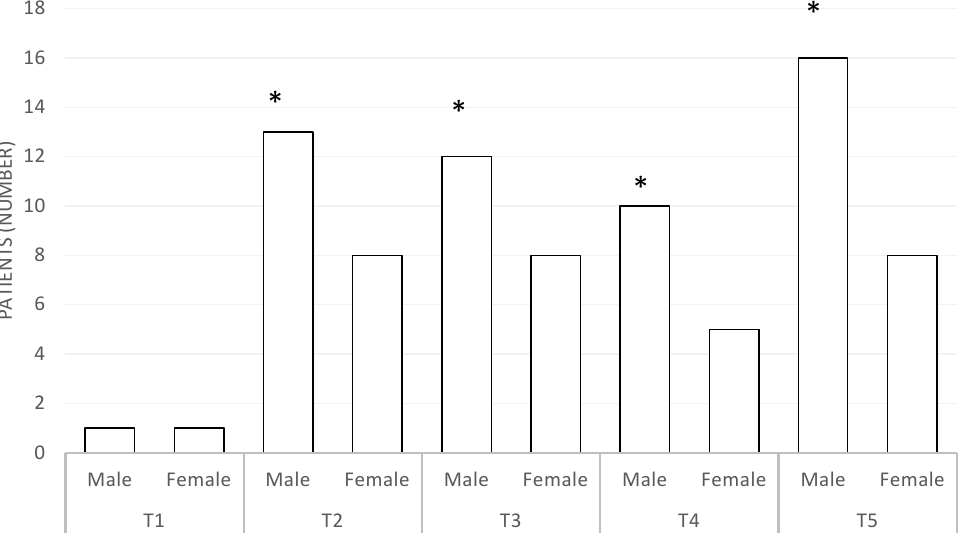
Figure 1. The gender difference of patients with protective values of IgG anti SARS-CoV-2 (>50 arbitrary unit/mL) during the follow-ups (T1, II dose of vaccine: 3 weeks after admission; T2: 2 months after T1; T3: 3 months after T2; T4: 6 months after T1, in this time, the patients underwent the III dose of vaccine; T5: 3 weeks after T4, end of the study). * p < 0.01 When we evaluated the IgG values with respect to gender, we found that men were significantly related to the expression of IgG ( p < 0.01; Figure 1), even if women presented significantly higher levels of IgG with respect to men ( p < 0.01; Figure 2).